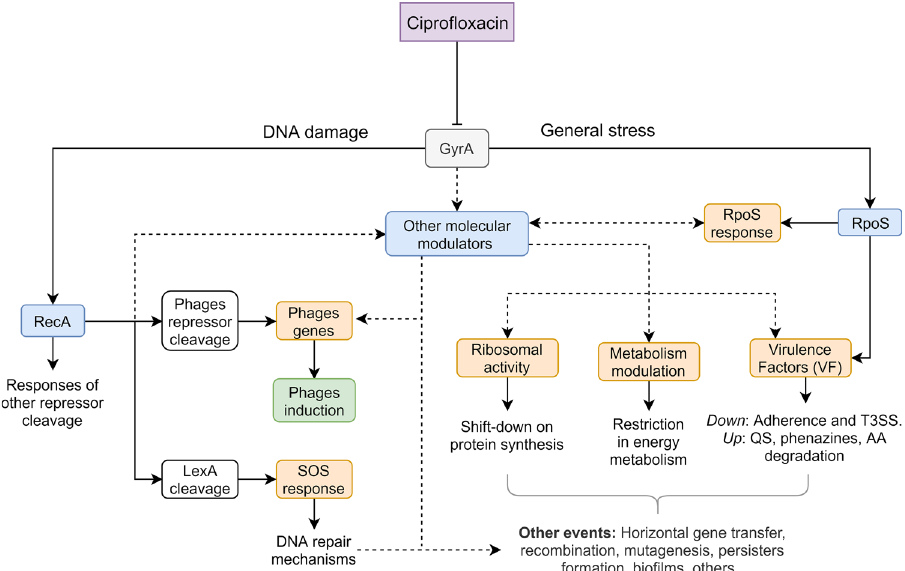
Figure 9. Conceptualization of effects of ciprofloxacin treatment in PaeAG1 at the molecular level. Effects of DNA damage triggers RecA increment, which cleaves different repressors such as LexA, inducing the SOS response, but also phages induction repressors, and other elements. The general stress induces the RpoS response, modulating different responses and virulence factors. Other modulators induce changes in the metabolic state of cells, expression of virulence factors, as well as the down-shift in ribosomal activity. Together, all changes imply modulation of multiple responses with pleiotropic effects at a molecular level and regulation of phenotypes to face the stress given by the